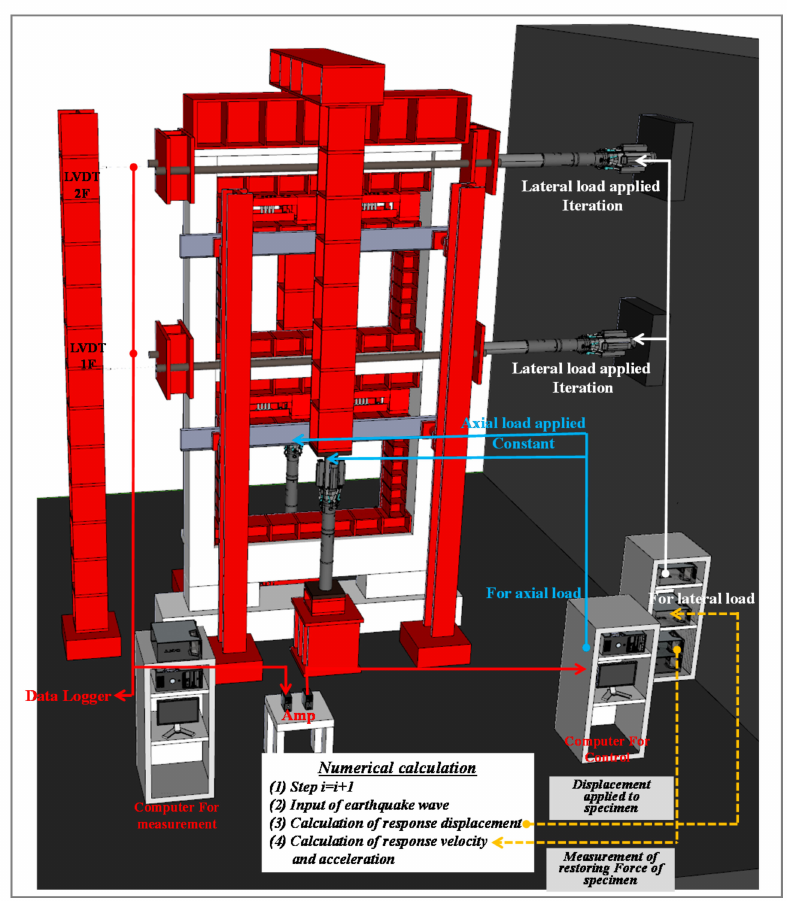
Figure 9. Illustration of the pseudo-dynamic testing system developed in the present